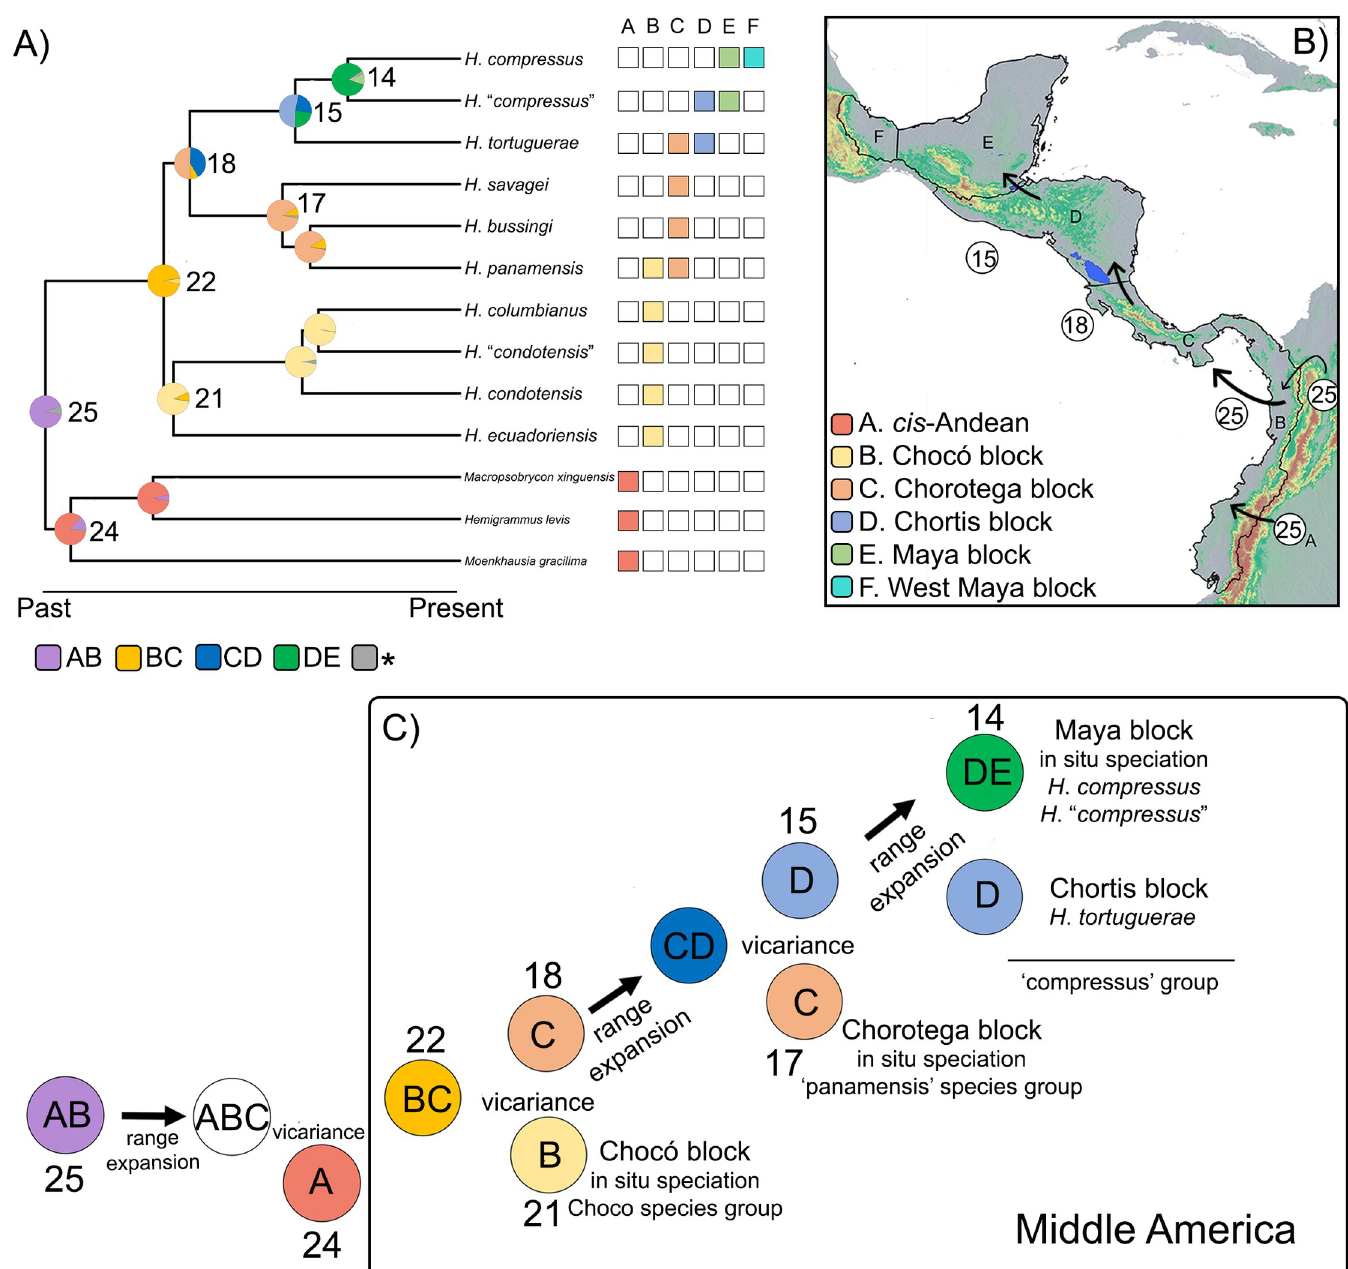
Fig 6. Biogeographic reconstruction of the colonization of Middle America by the genus Hyphessobrycon (i.e., trans -Andean Hyphessobrycon ) based on the DEC- like model. A) Ancestral range estimation based on the best biogeographic model DEC-like on the 75% maximum likelihood pruned topology (see Methods). Pie charts on nodes represent the probability of the estimated ancestral ranges for each clade. Boxes to the right show present-day presence/absence of trans -Andean Hyphessobrycon in the geological blocks (i.e., biogeographic units) considered in this analysis. Boxes below the phylogeny show ancestral ranges estimated that encompass two geological blocks, gray with asterisk represent other ancestral ranges. B) Map of Middle America depicting geological blocks and their letter codes. Numbers on circles indicate nodes in A for which we inferred a dispersal event (colonization) to a new geological block. C) Schematic representation of major biogeographic events during the colonization of Middle America by Hyphessobrycon . Circles represent nodes on the phylogeny of trans -Andean Hyphessobrycon , node numbers above or below circles, and their most likely ancestral range estimated (see A), circles without node number represent an inferred event (i.e., range expansion) that occurred in the previous node.